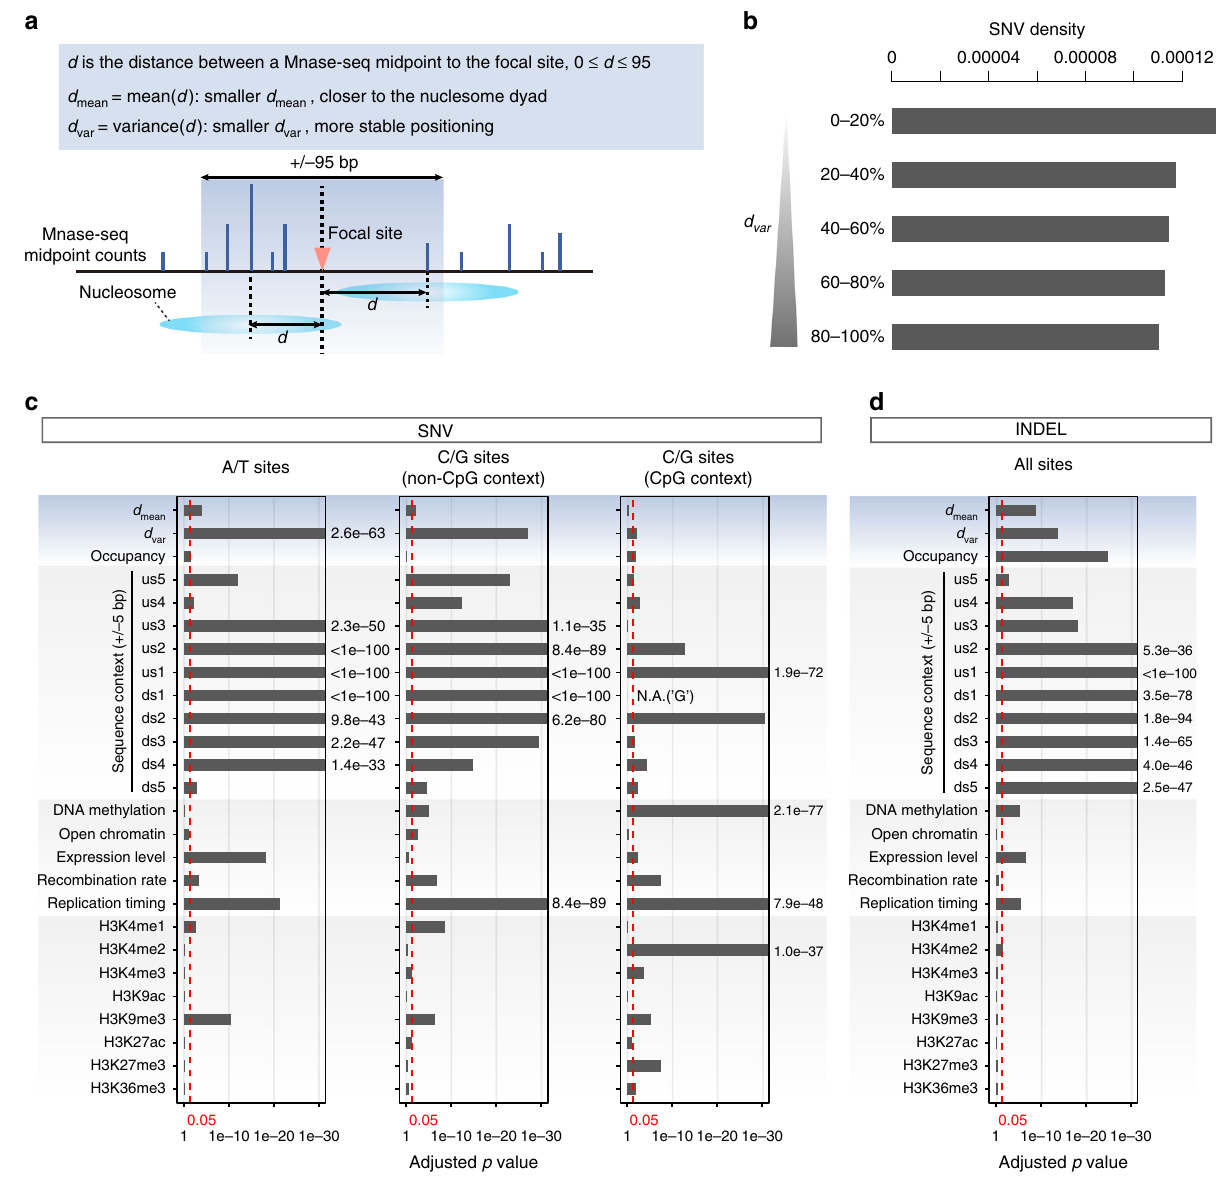
Fig. 2 Evaluating the contribution of nucleosome organization to mutation rate variation. a Schematic diagram describing two nucleosome positioning- related variables ( d mean and d var ) relative to a given genomic position. b Classifying the genome into fi ve equal portions by d var and calculating the SNV densities. c , d Independent statistical signi fi cance of potential contributing factors to mutation rate variation, having controlled for other factors; b for SNVs and c INDELs. Tests for SNVs were performed separately at A/T and C/G sites (non-CpG and CpG contexts, respectively). Vertical red lines indicate the threshold for statistical signi fi cance (0.05). The p values were from the likelihood-ratio tests and were adjusted for multiple testing with Benjamini – Hochberg correction. us upstream; ds downstream. Source data are provided as a Source Data fi